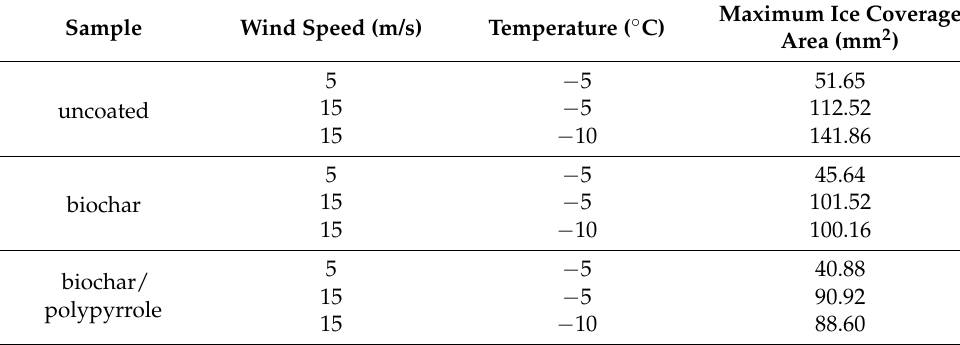
Table 7. The maximum ice thickness of uncoated biochar and biochar/polypyrrole. Sample